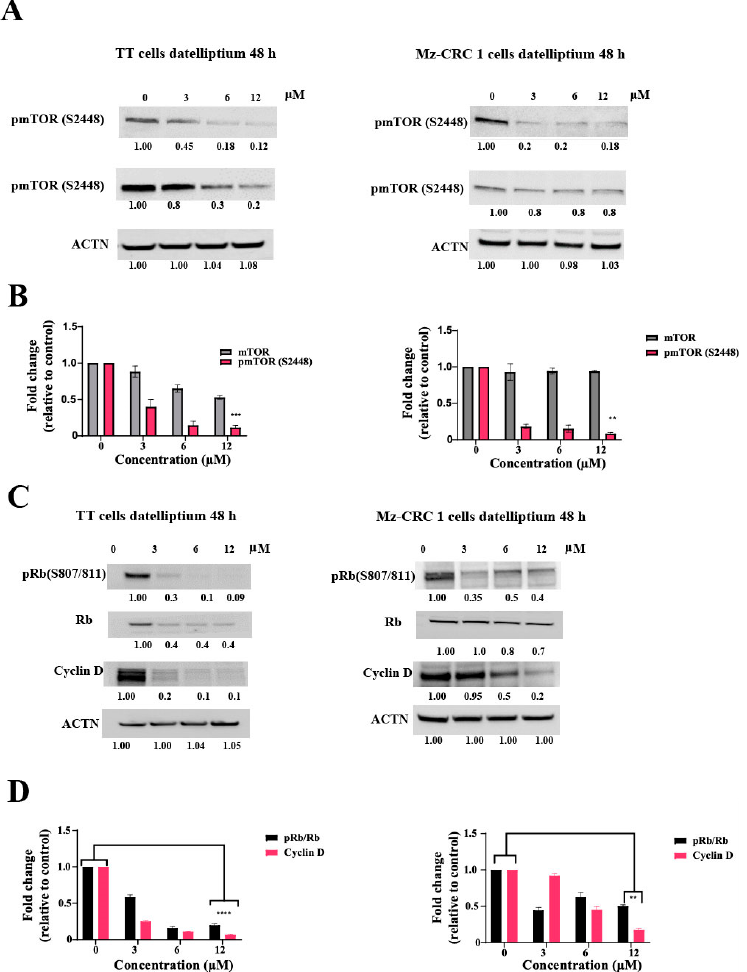
Figure 5. Datelliptium downregulates cyclin D1 protein expression levels in TT- and MZ-CRC-1 cells. ( A ) Cells were treated with datelliptium for 48 h at several concentrations, and the levels of phosphorylated and total mTOR protein were measured by western blotting. ( C ) TT- and MZ-CRC-1 cells were treated for 48 h with indicated concentrations of datelliptium and harvested to get protein lysates. The cellular lysates prepared from TT- and MZ-CRC-1 cells were analyzed by western blot using specific antibodies against cyclin D1, Rb, or pRb protein. Actin served as a con- trol for equal loading. ( B ) and ( D ) Densitometry analysis of the western blotting of ( A ) and ( C ), respectively. pmTOR, mTOR, cyclin D, and pRb/Rb were normalized to their basal expression ( n = 3, **** p < 0.0001, *** p < 0.001, and ** p ≤ 0.01).